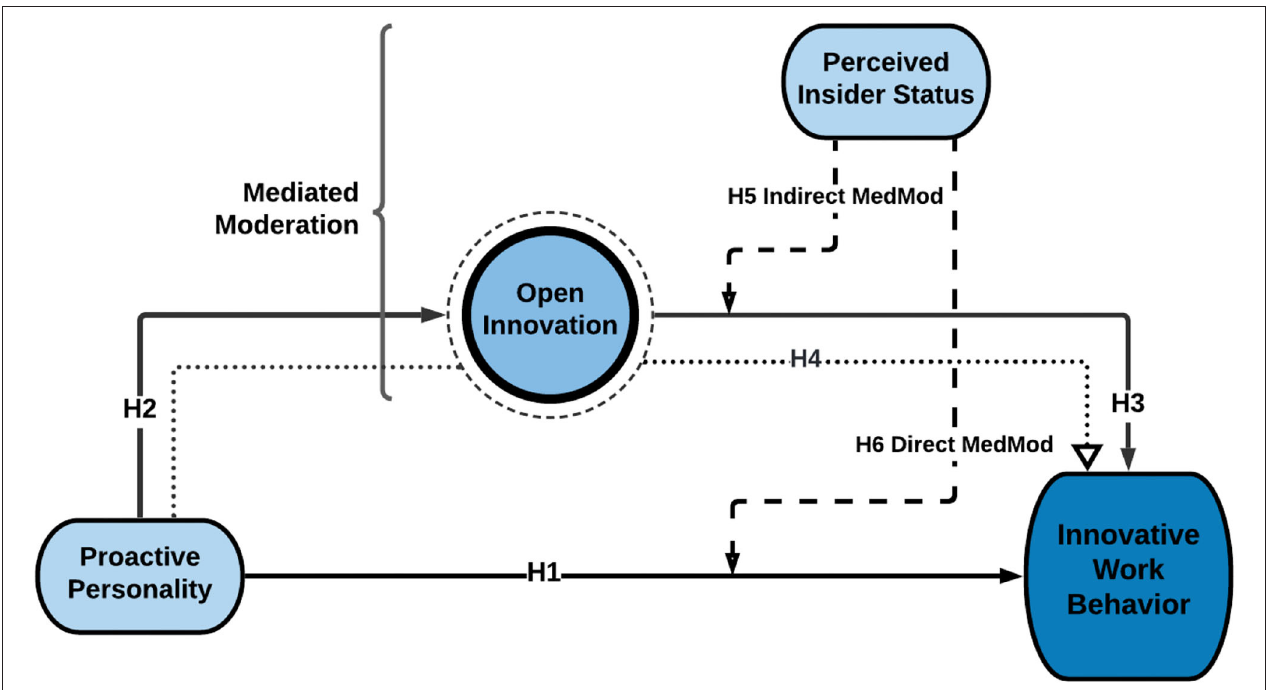
FIGURE 1 | Conceptual model. Source: